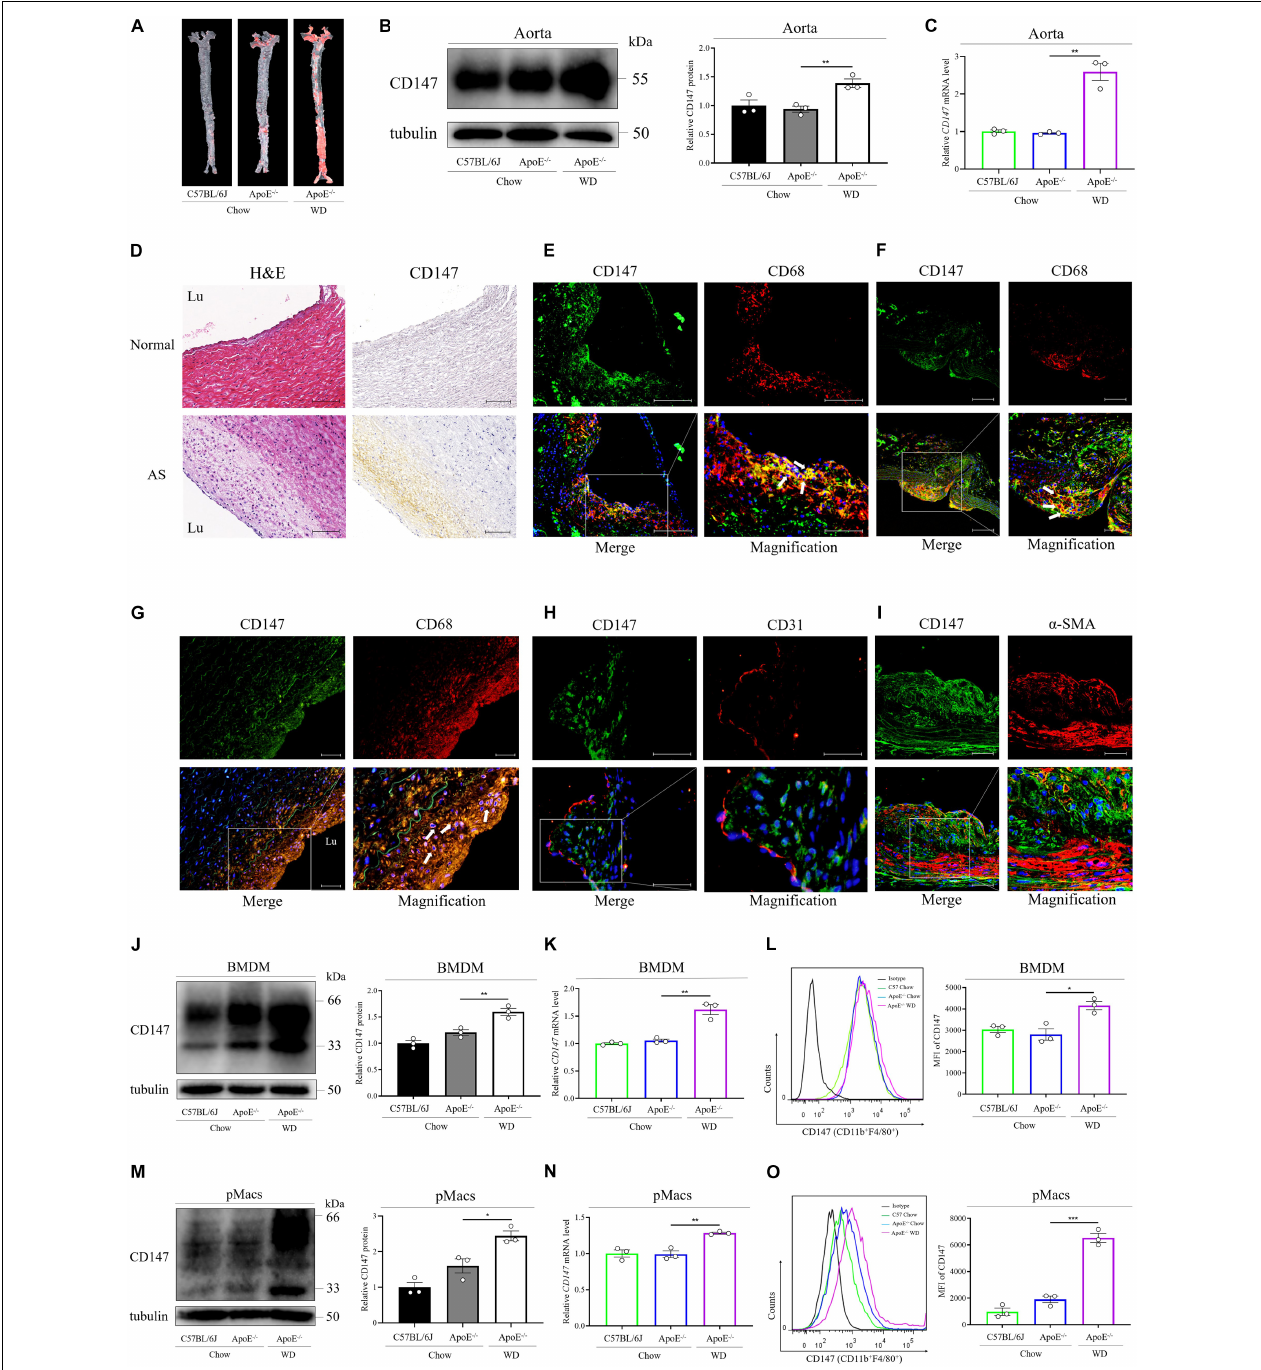
FIGURE 1 | CD147 is upregulated in macrophage foam cells during atherosclerosis. (A) Atherosclerotic lesions in chow-fed C57BL/6J and ApoE - / - mice and WD-fed ApoE - / - mice were stained with Oil Red O. (B) CD147 expression in aortas of mice from each group was detected by western blotting. CD147 expression is presented relative to that of tubulin (right). (C) CD147 mRNA levels were compared among the aortas of chow-fed C57BL/6J and ApoE - / - mice and WD-fed ApoE - / - mice. (D) Immunohistochemical staining for CD147 in healthy human arteries and atherosclerotic plaques after autopsy, also stained with H&E to show histological features. Scale bar, 100 µ m. (E–G) Immunofluorescence staining for CD147 and CD68 in the aortic sinus (E) and aortic arches (F) of 16 w WD-fed ApoE - / - mice and in human atherosclerotic lesions (G) . (CD147, green; CD68, red; DAPI, blue; colocalization, yellow merge, see arrows). The scale bars in (E) are 100 µ m and 50 µ m, in (F) are 100 µ m and 50 µ m, in G is 50 µ m. (H,I) Atherosclerotic plaques in WD-fed ApoE - / - mouse aortic sinus stained for CD147 and CD31 (H) or α -SMA (I) . The scale bars in (H,I) are 50 µ m. (J–O) Western blotting (J,M) , RT-PCR (K,N) , or flow cytometry (L,O) of CD147 expression in CD11b + F4/80 + BMDMs (J–L) and pMacs (M–O) isolated from normal chow-fed C57BL/6J and ApoE - / - mice and WD-fed ApoE - / - mice. Right panel in (J,M) : CD147 expression is presented relative to that of tubulin. Right panel in (L,O) : quantification of the MFI of CD147 in each group. Data represent the mean ± SEM. of n = 3 biologically independent experiments. * P < 0.05, ** P < 0.01, *** P < 0.001. Frontiers in Cell and Developmental Biology |